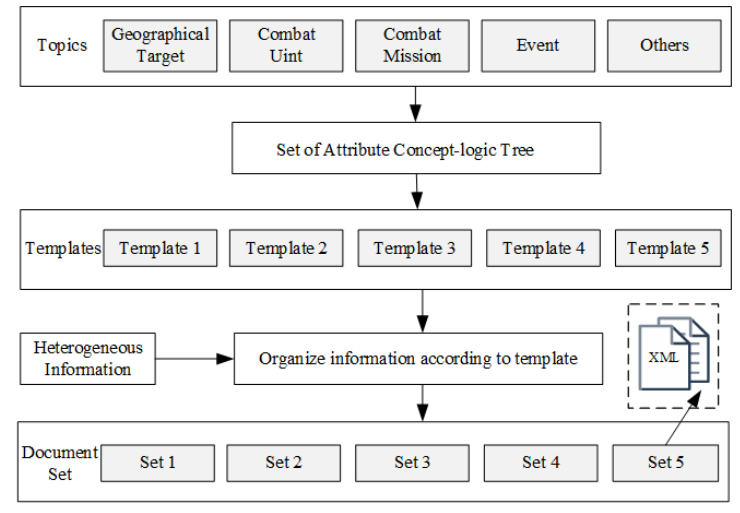
Figure 8. Structure of the entity class classification